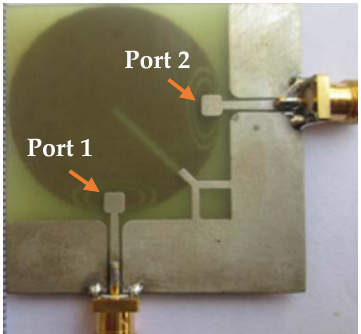
Figure 13. Circular patch shared radiator [75].